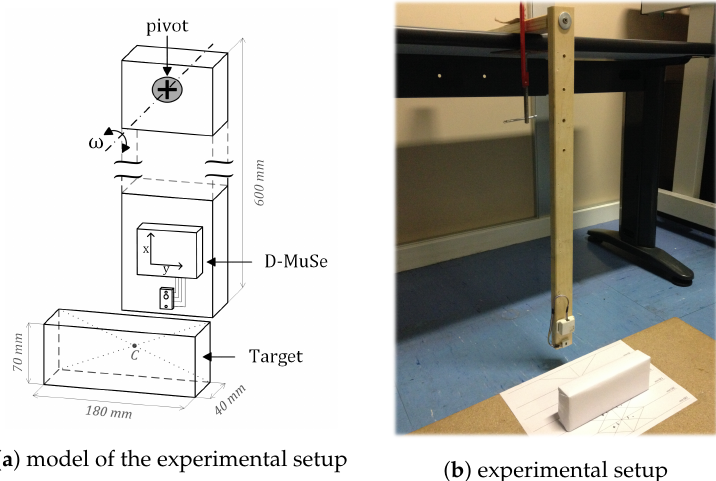
Figure 5. A wooden pendulum with the magneto-inertial measurement unit (MIMU) and the Infrared Time-of-Flight proximity sensor (IR-ToF) attached to its distal end. The stationary target was positioned in front of the pendulum.